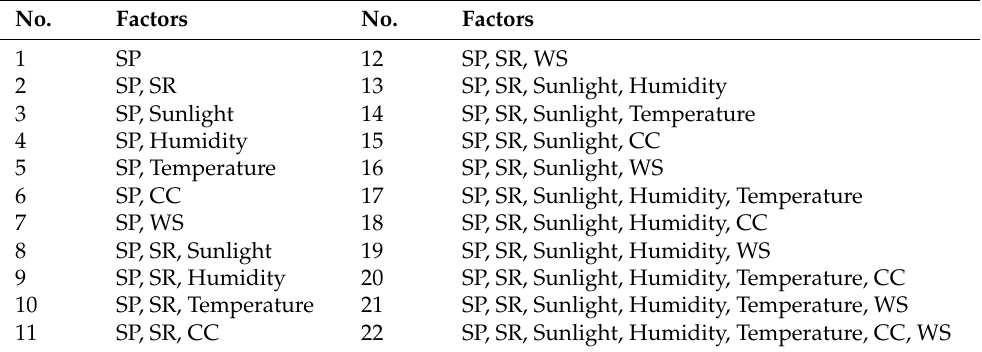
Table 4. Multivariate numerical